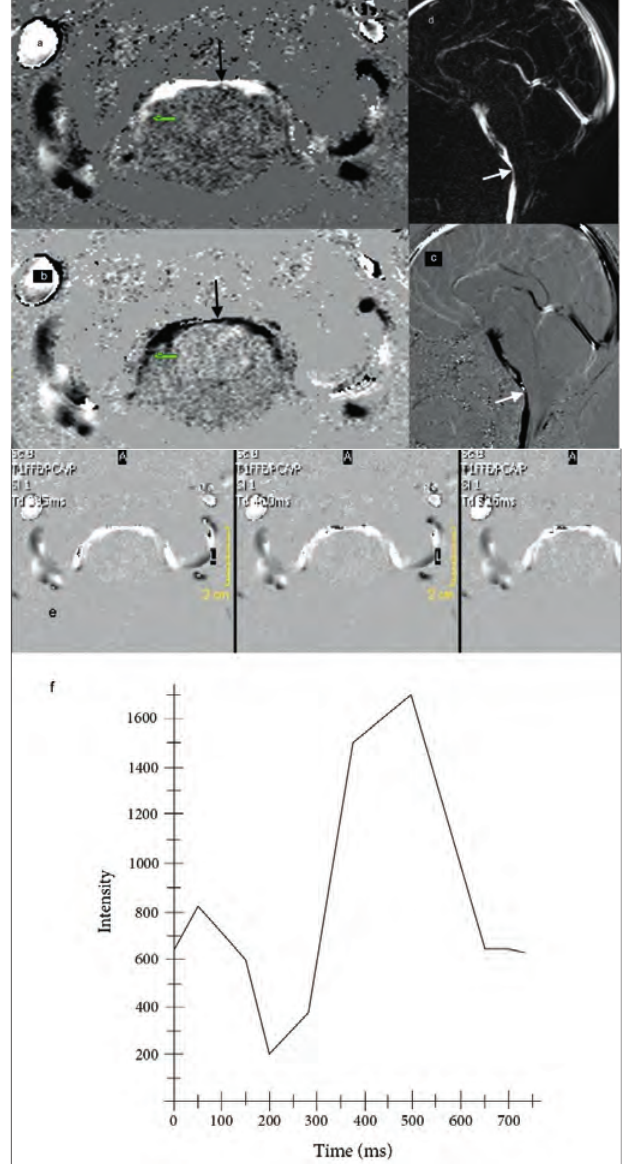
Fig. 5. (a - d) Axial phase contrast CSF flow study demonstrating baseline and follow-up imaging in a patient with Chiari I malformation. (e - f) Baseline axial and sagittal PC-MRI demonstrates absence of flow posteriorly at the foramen magnum, and limited flow at the midline anteriorly (black arrow). Follow-up imaging demonstrates change in CSF flow to a unidirectional pattern represented as only high signal on the sagittal PC-MRI and with high flow velocity above the baseline on the graphic